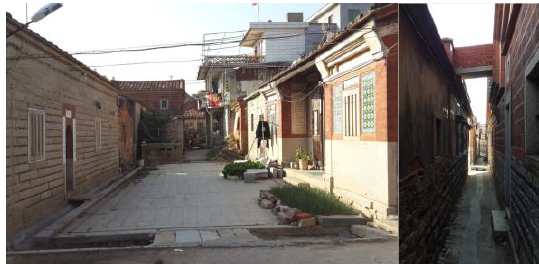
Figure 3. ―Cheng‖ in front of the ancient residence of the Changs and the 1-meter interval